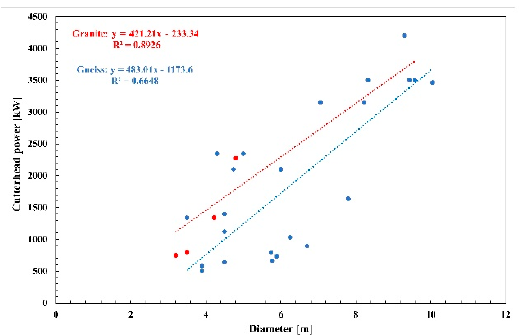
Figure 8. Correlation between the diameter and the power supplied to the head due to the excavation in granites and gneisses by open TBMs.